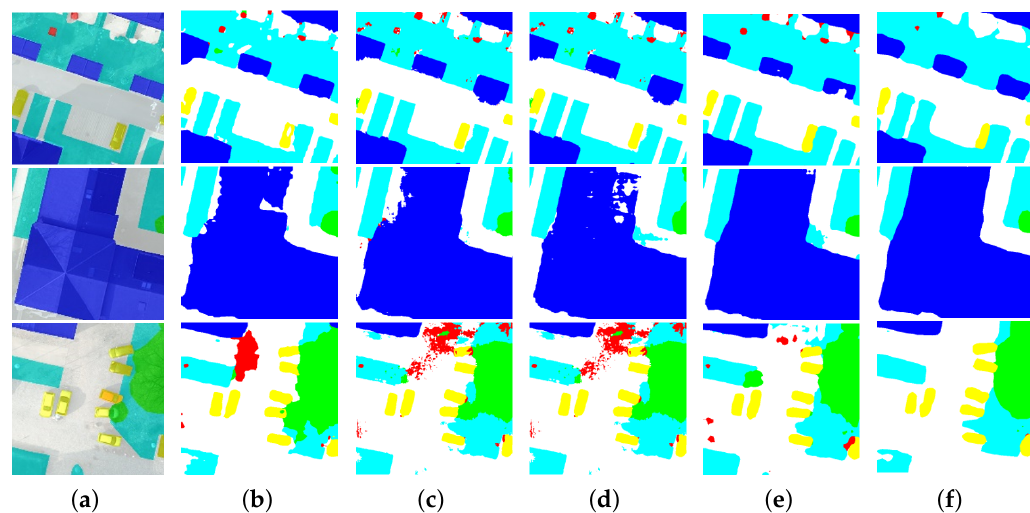
Figure 7. Visual effect comparison of Potsdam-B test set; ( a ) the superposition of the original image and the label; ( b ) FCN-8S; ( c ) U-Net; ( d ) DeeplabV3+; ( e ) PSPNet; ( f ) NFSNet.